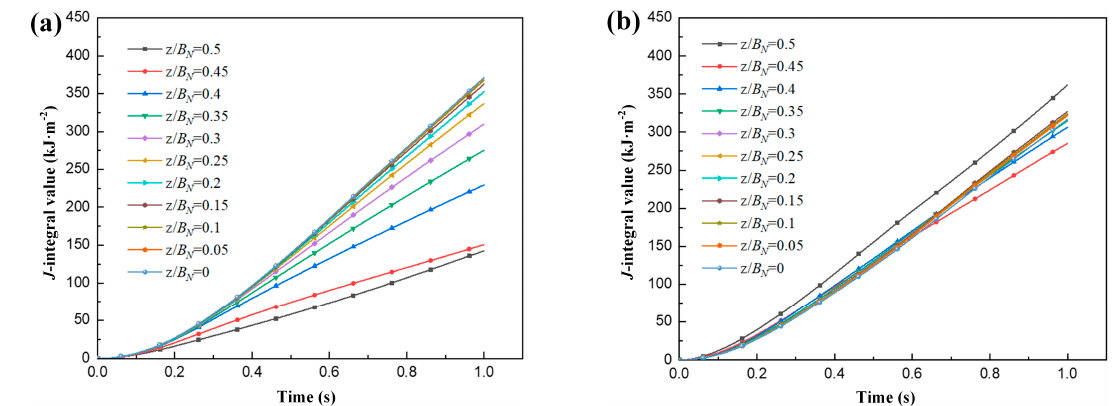
Figure 11. J -integral values from the center to the edge along the thickness direction: ( a ) SENB20 without side grooves; ( b ) SENB20 with side grooves.